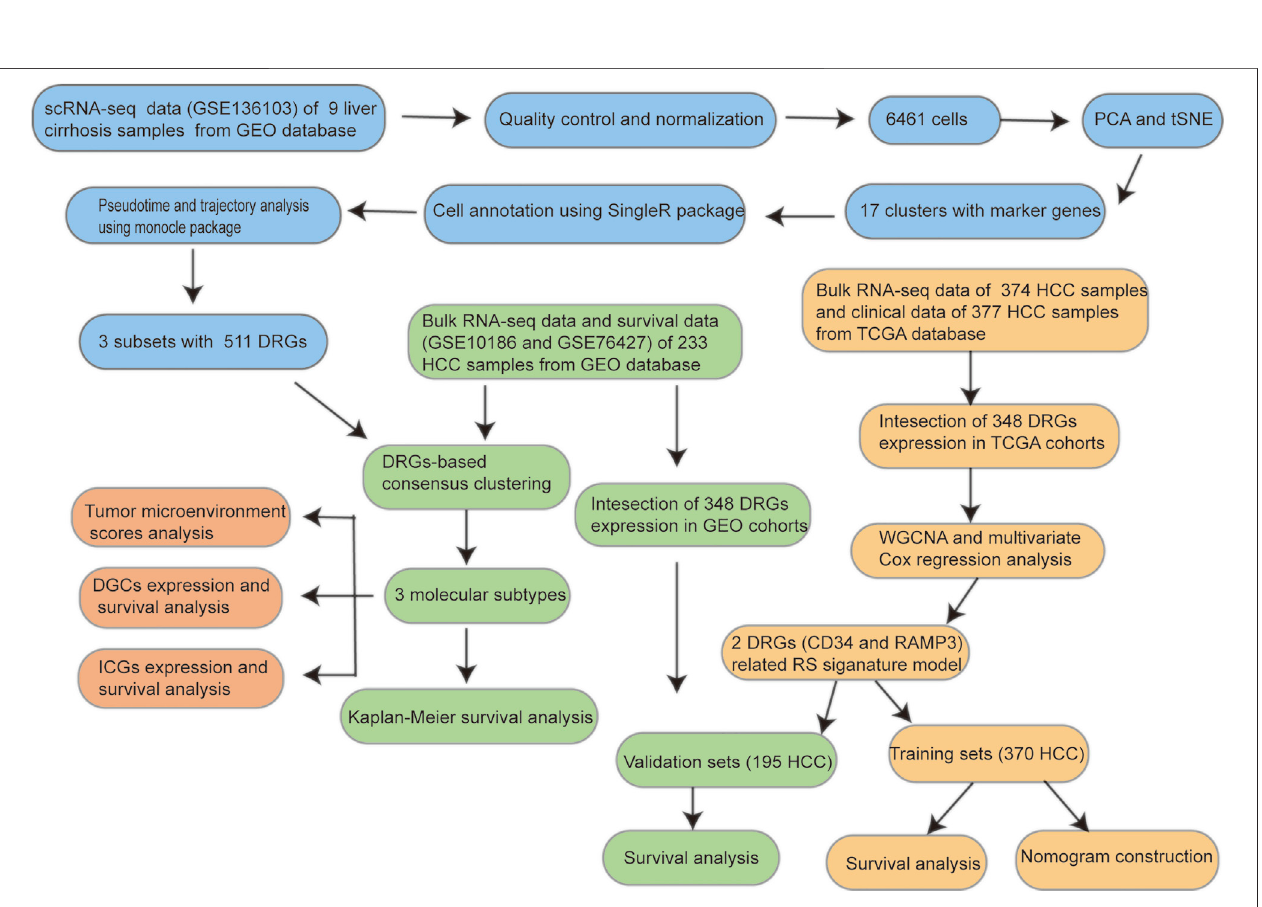
FIGURE 1 | The work fl ow of this